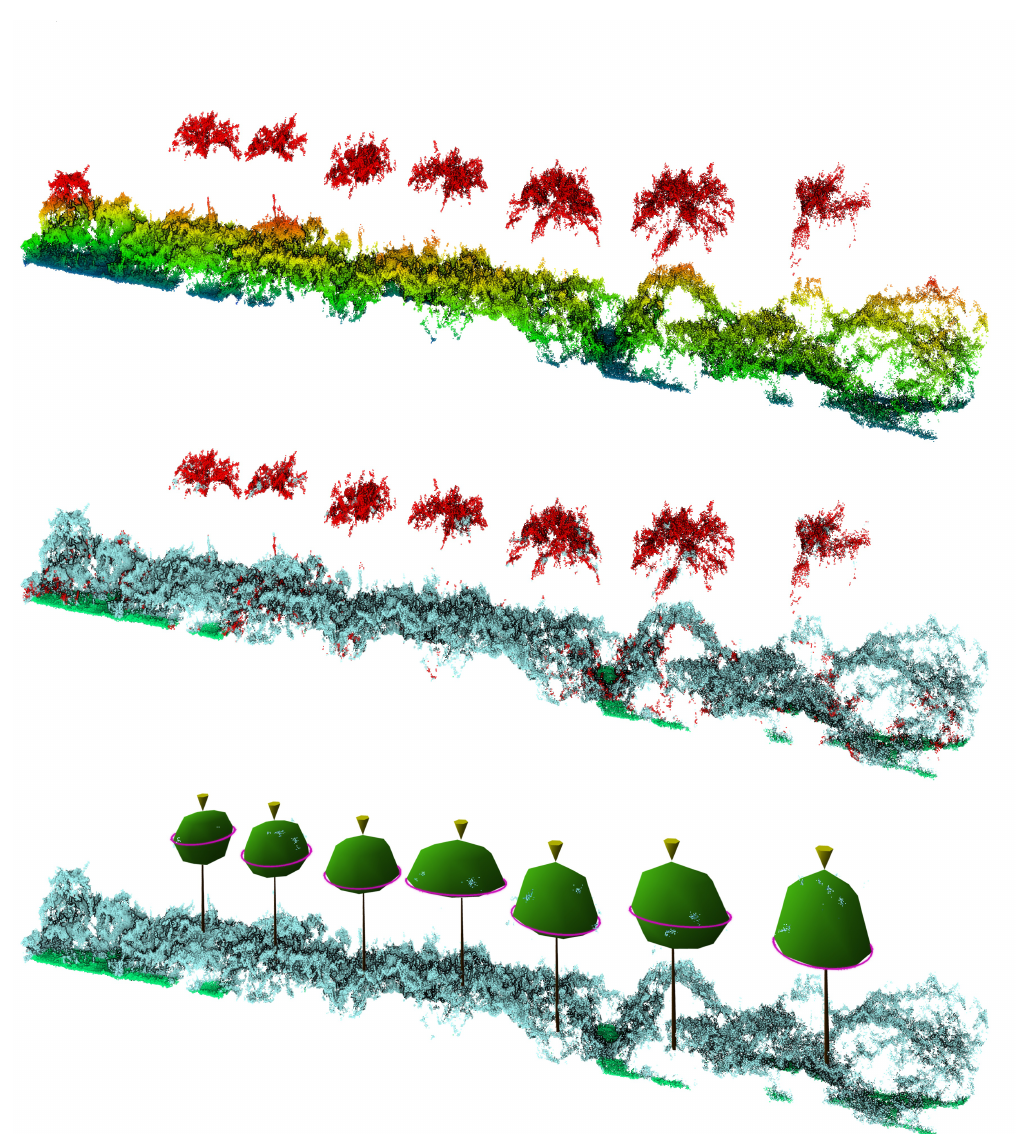
Figure 4: Transects (100m data set) of the point cloud with height color gradient (top); with classification results, palm = red, other vegetation = blue, ground = green (center) and with modeled palms (bottom). Green shapes represent the convex hull of the crown, vertically surrounded by crown margins (purple). Yellow cones represent the top (z) and the position